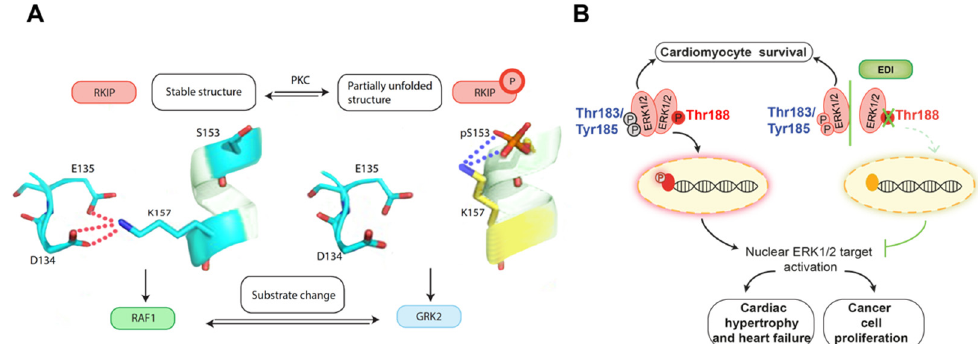
Figure 1. ( A ) Depicted is the phospho-theft mechanism, a novel phosphorylation-induced salt bridge theft. Specifically, the lysine located at residue 157 forms a salt bridge with two negatively charged residues on a neighboring polypeptide chain, D134 and E135. After PKC-mediated phosphorylation of RKIP at S153, the strong negative charge located just 4 residues away from K157 is enables it to effectively ‘steal’ the positively charged residue from the negatively charged residues in the neighbor- ing salt bridge and to form a new salt bridge, resulting in a partially unfolded structure that may support the substrate change of RKIP from Raf-1 to GRK2. ( B ) pERK T188 autophosphorylation is induced after ERK1/2 dimerization and G βγ binding, which triggers nuclear ERK target phosphory- lation. It is causatively associated with pathological cardiac hypertrophy and cancer cell proliferation. Interference with ERK dimerization by the ERK dimerization inhibitory peptide “EDI” prevents pERK T188 , nuclear ERK signaling, cancer cell proliferation, and maladaptive cardiac hypertrophy without interfering with ERK1/2-mediated pro-survival